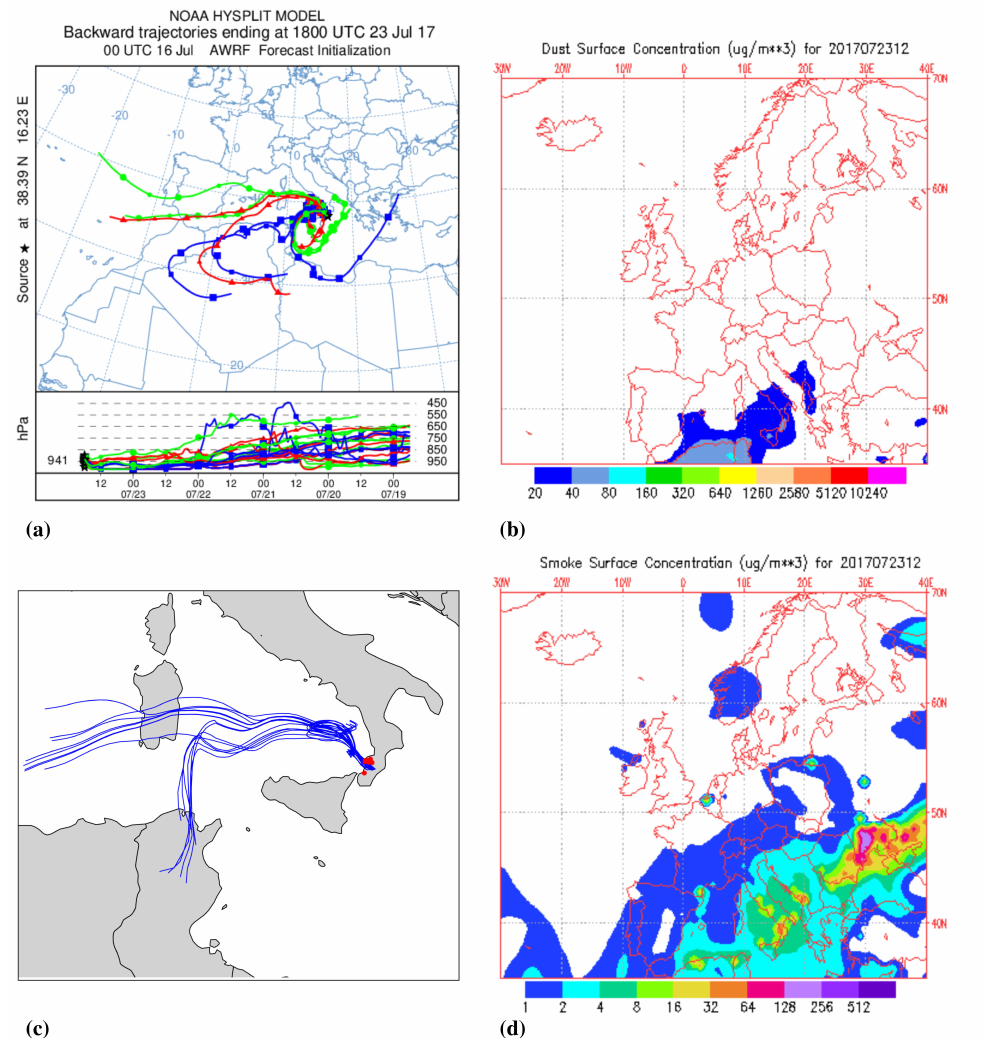
Figure 7. Concurrent episodes of Saharan dust (SD) confirmed by ( a ) 120 h WRF-HYSPLIT back-trajectories and ( b ) NAAPS dust Surface Concentration, and wildfire (WF) events confirmed by ( c ) 48 h WRF-HYSPLIT back-trajectories VIIRS fire detections intercepted and ( d ) NAAPS Smoke Surface Concentration. All maps refer to 23rd of July, 2017. Table 2. Statistics of PM 2.5 and PM 10 concentrations and their ratio (mean value and 25–75th percentile) for the whole 2017, the whole 2017 without summer, summer season, summer smoke days, summer smoke + SD days, summer SD days, and summer BKG days. For each period, the corresponding number of days (N Days) is also reported.